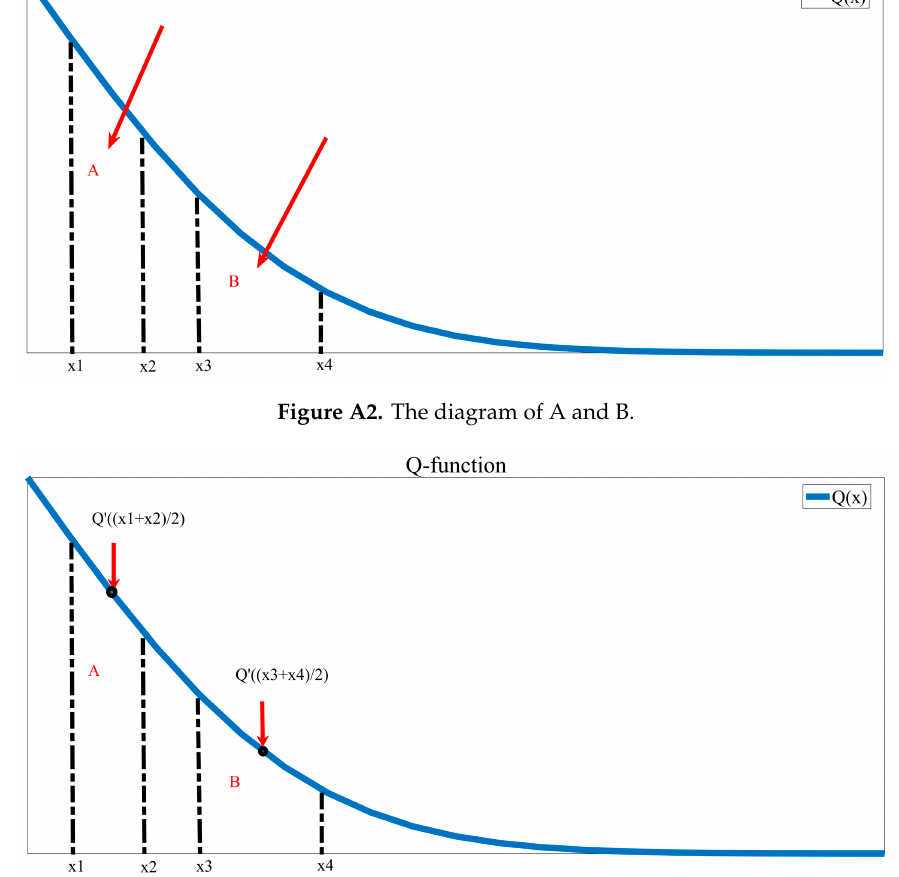
Figure A3 . Approximate schematics of Area A and B